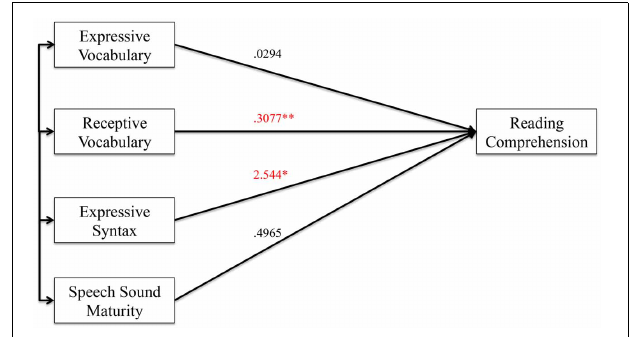
FIGURE 4 | Total effect model (without mediator) for reading comprehension. Figure 4 shows the total effect model for preschool language and speech measures on reading comprehension.Unstandardized coefficients of correlations are included in model. Coefficients marked with a single asterisk are significant at the p < 0 . 05 level. Coefficients marked with a double asterisk are significant at the p < 0 . 01 level.